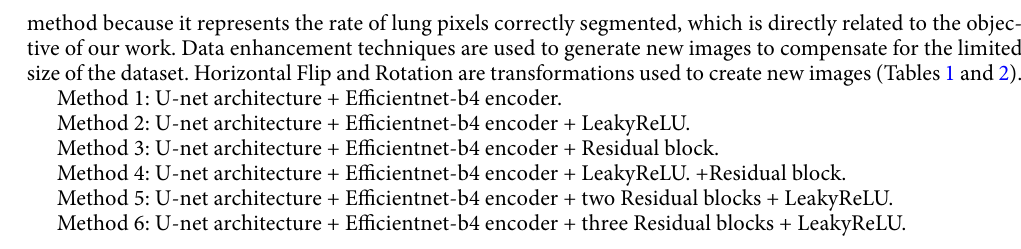
Figure 4. The first row is the lung segmentation result in the JSRT dataset, and the second row is the segmentation results in the MC dataset. The ground-truth lung boundary is depicted in green, and the automatically segmented lung boundary by our method is presented in red